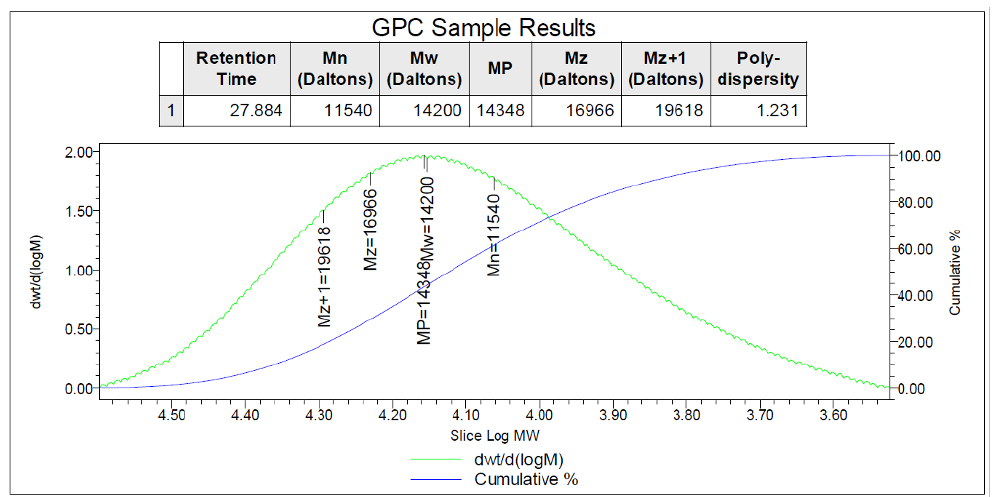
Figure 7. GPC data for